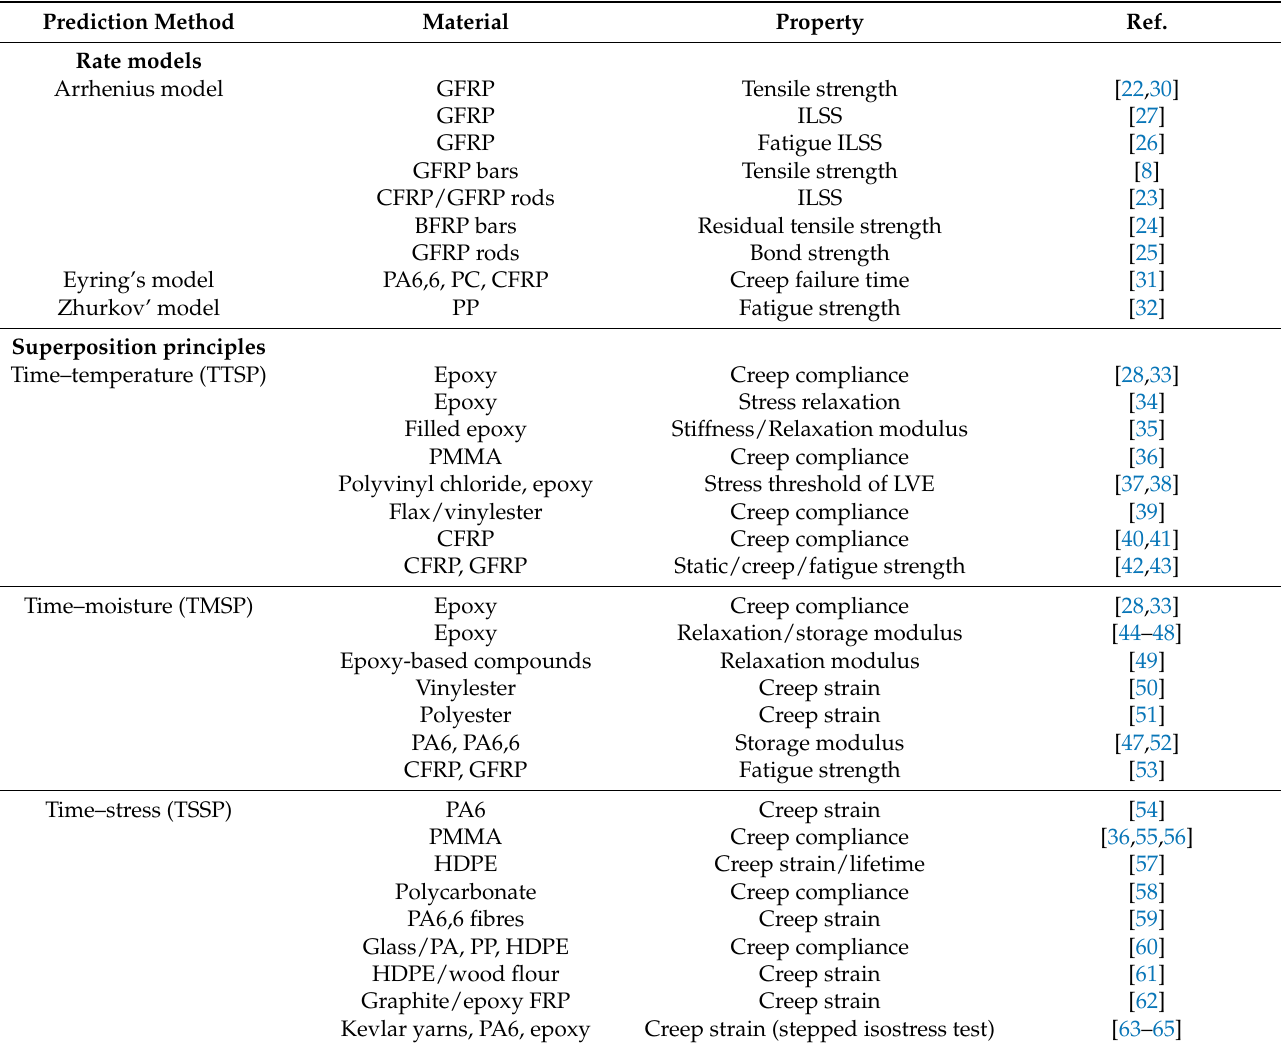
Table 1. A condensed list of recent works on methods for predicting long-term mechanical properties of polymers and polymer